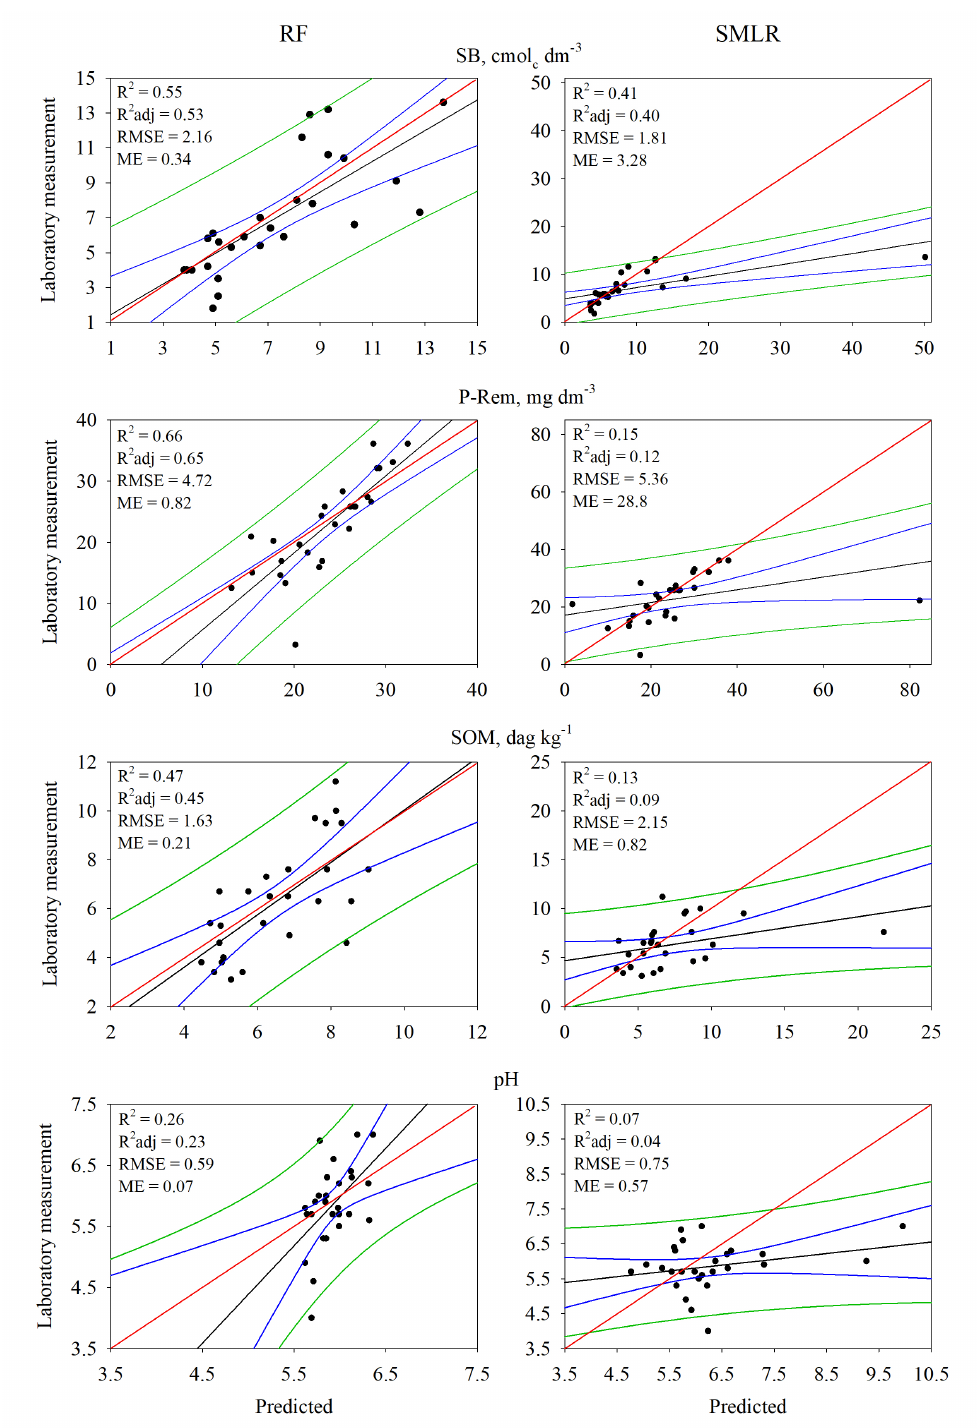
Figure 5. Validation of soil attributes predicted by Random Forest (left) and stepwise multiple linear regression (right) models, from soil samples collected in Lavras, Minas Gerais,